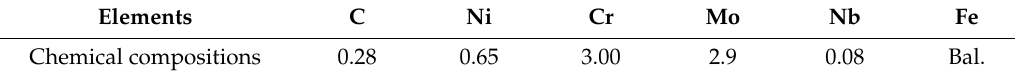
Table 3. 25Cr3Mo3NiNb steel composition (mass fraction, %).